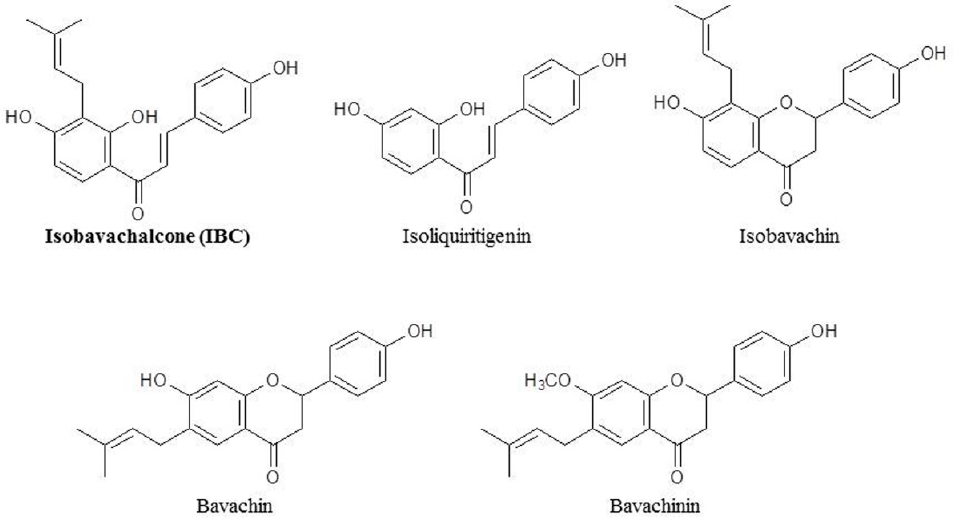
Figure 1. Chemical structures of isobavachalcone and its analogues.